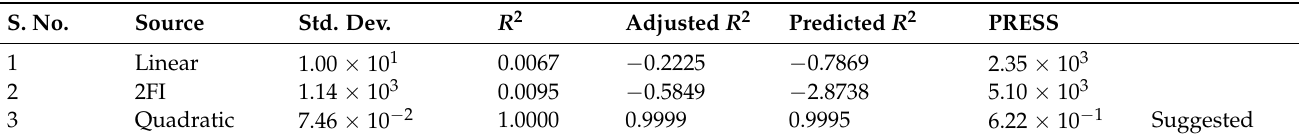
Table 3. Summary statistics of the BBD model for development of the HPLC method.